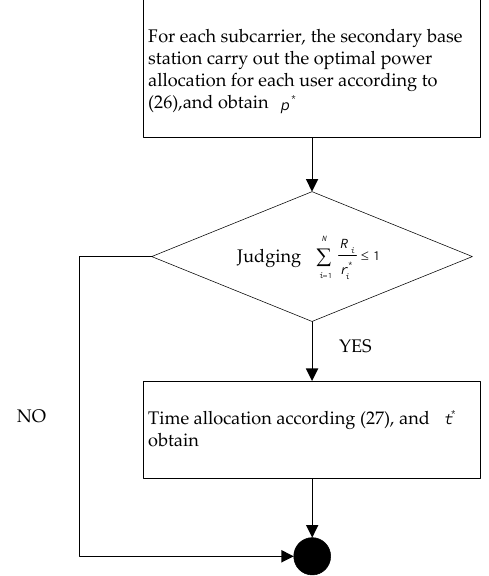
Figure 5. Spectrum pricing and allocation scheduling.